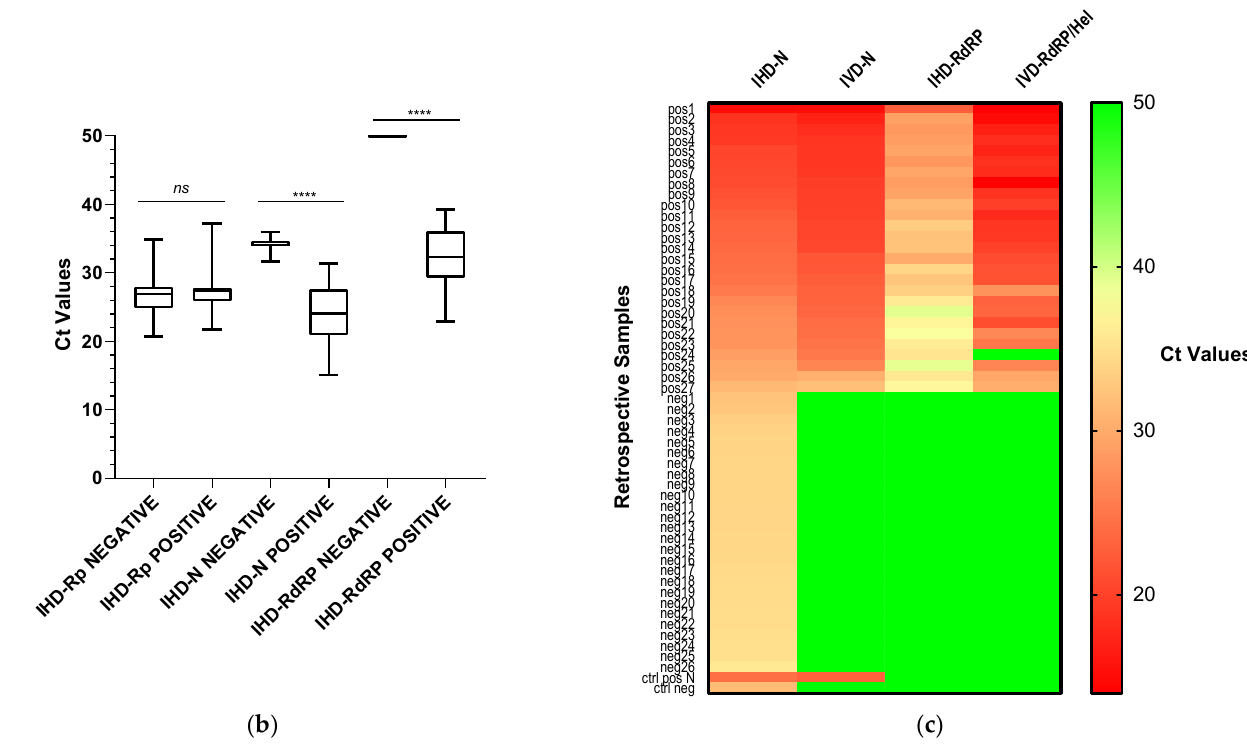
Figure 1. Pilot set up of SARS-CoV-2 detection by multiplex RT-qPCR on retrospective samples. ( a ) Scatter plot of Ct values for viral N and RdRP targets in 26 negative and 27 positive-retrospectively diagnosed patients detected by in-house developed (IHD) and IVD multiplex RT-qPCR. ( b ) Box and whiskers plot representing the differences of Ct values for RP , N and RdRP targets between positive and negative samples. Statistical significance of Ct value differences between negative and positive samples were measured with unpaired Welch’s t tests (****: p value < 0.0001; ns: not significant). ( c ) Heat map representing IHD-Ct values in comparison to amplification signals obtained at time of diagnosis through commercially available kit suitable for in vitro diagnostic use (IVD).